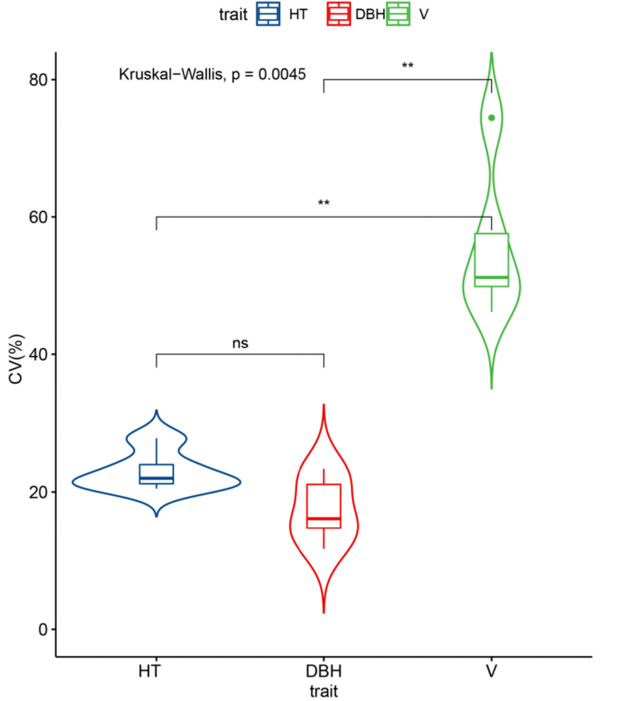
Figure 1. Coefficients of variation for traits. “**” indicates a significant difference at the 0.01 level, “ns” means not significant. The results of Duncan’s multiple range tests ( α = 0.05) among provenances of different forest ages showed that the differences of between provenances for each growth trait were significant (Table A1). At age 2 and age 3, the best performance of HT, DBH, and V was registered by provenance 10, while in the sixth year, the best performance of HT, DBH, and V was registered by provenance 3, indicating that the efficiency of early selection of N. cadamba is unstable and the time of early selection should not be too early. 3.2. Variance Analysis and Heritability Estimates Using a linear mixed model with block as a fixed effect, and provenance, family within provenance, provenance–block interaction, and the family–block interaction as random effects, we subjected HT, DBH, and V at different ages to variance analysis (Table 3). ANOVA showed that the effects of block as a fixed effect on each trait were extremely significant ( p < 0.001). For the random effects, the effects of provenance on each trait were significant, except the HT2 and V2, and family effects were significant in all traits except HT2. In general, the highly significant effects ( p < 0.001) of provenance–block interaction were mainly observed at age 2, age 3, and age 4, and the significant effect of family–block interaction were mainly observed at age 2, age 3, age 4, and age 5. Except for the HT, with increasing of tree’s age, the effect of interactive factors on the traits became smaller and smaller.